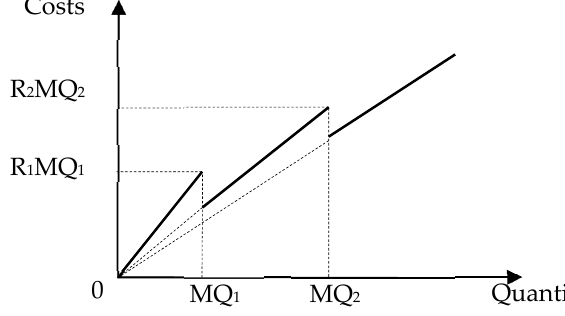
Figure 5. Direct material cost function.